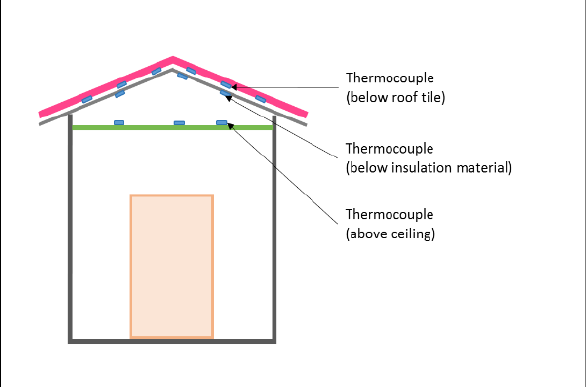
Figure 8: Diagram of thermocouple locations